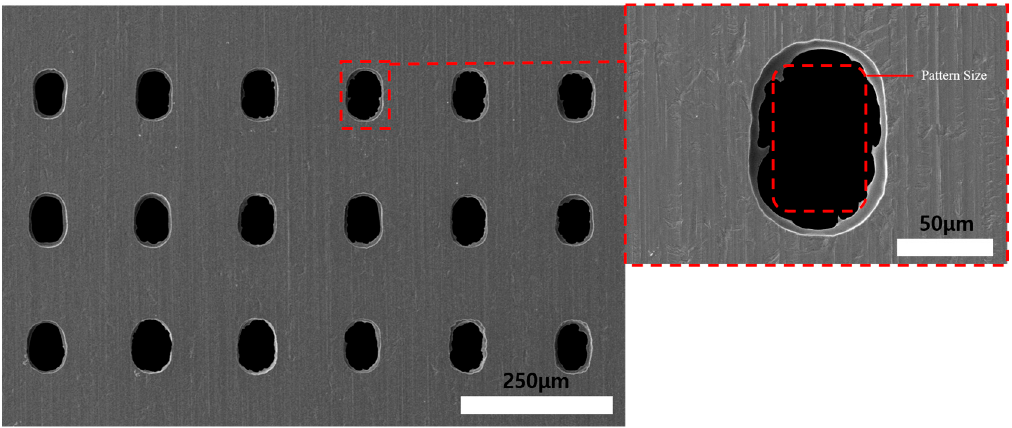
Figure 17. SEM images of 15 min electrochemical machined Invar thin film after wet etching (photoresist coating opposite face etching) for 5 min.